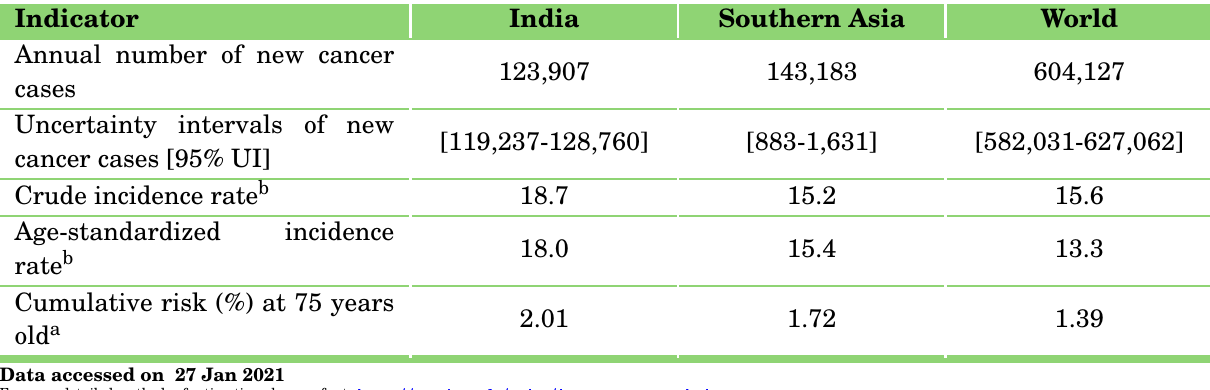
Table 2: Cervical cancer incidence in India (estimates for